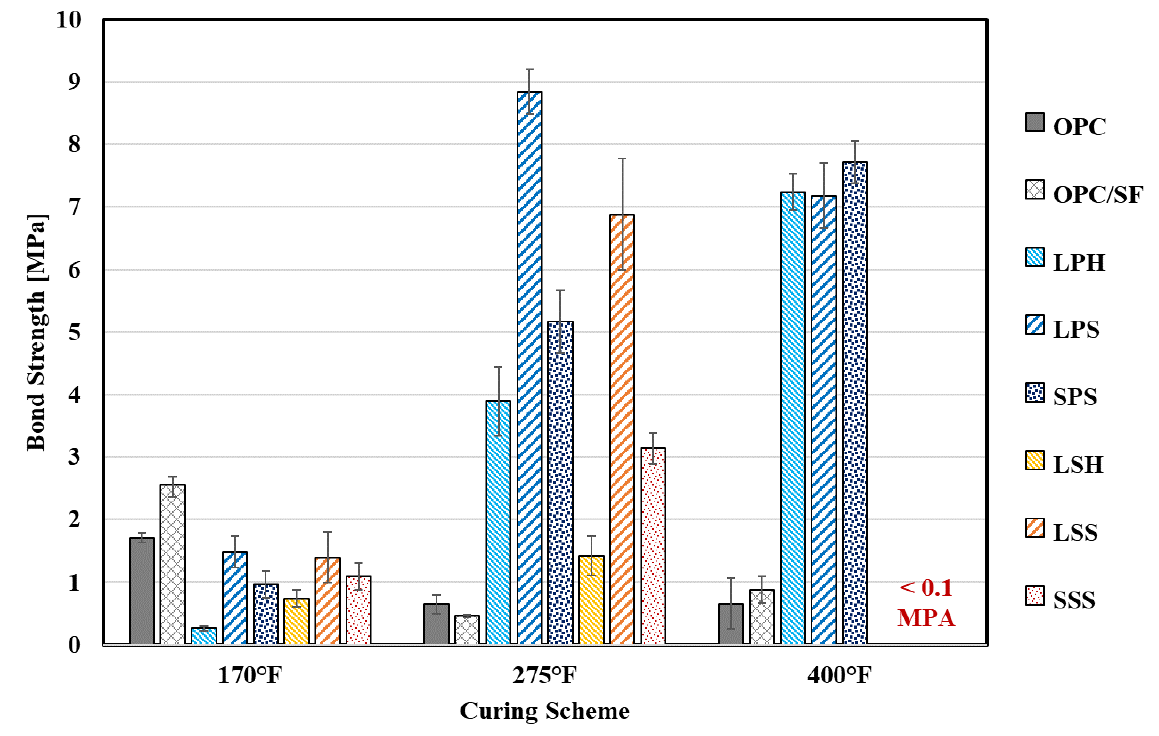
Figure 4. Three-day bond strength for OPC and geopolymer formulations cured with different curing schemes (indicated by BHST value, see Table 3). Error bars represents the range of bond strengths values measured for each mixture. A bond strength of less than 0.1 MPa was observed for geopolymers activated with LSS and SSS at 400 ◦ F